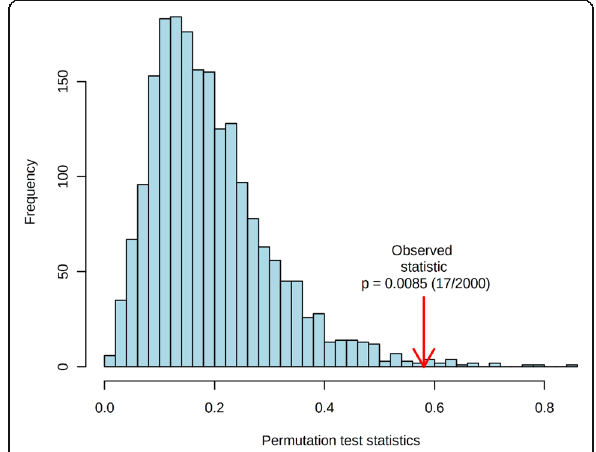
Fig. 14 Permutation test statistics of PLS-DA of groups according to